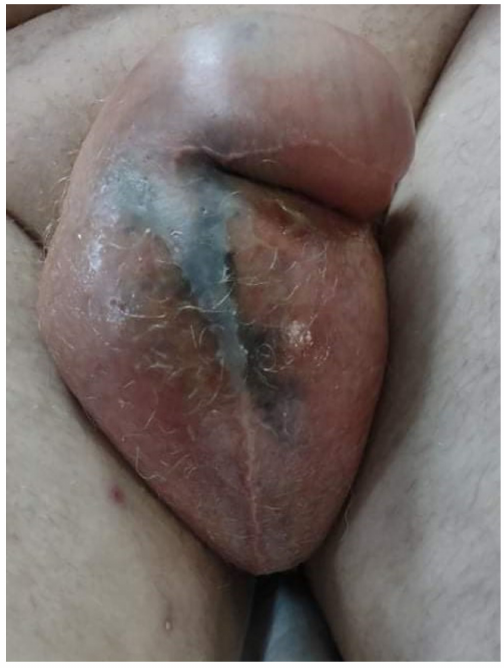
Figure 3. Patient’s Fournier gangrene.